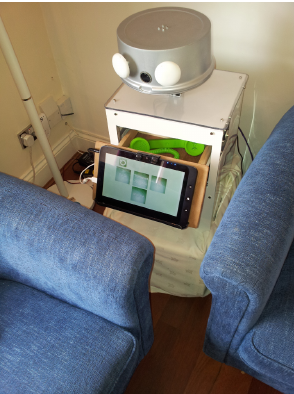
Figure 3: The Stationary Sunflower Robot (SF2) extents its tray for the user to answer a Skype